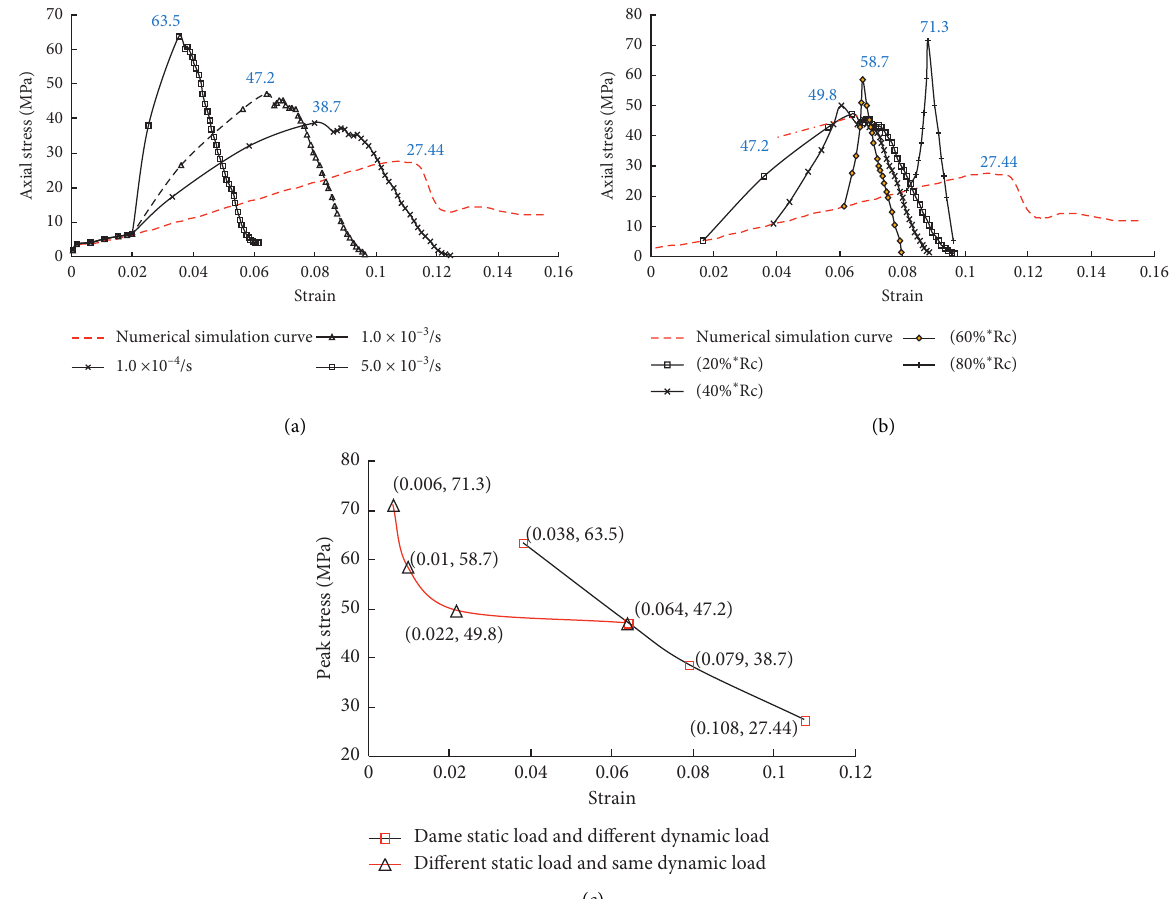
Figure 10: Stress-strain curves of coal pillar under dynamic and static combined load: (a) stress-strain curves for superimposed disturbances with the same static load and different dynamic loads; (b) stress-strain curve for superimposed disturbance of the same dynamic load with different static loads; (c) peak point stress-strain curve.